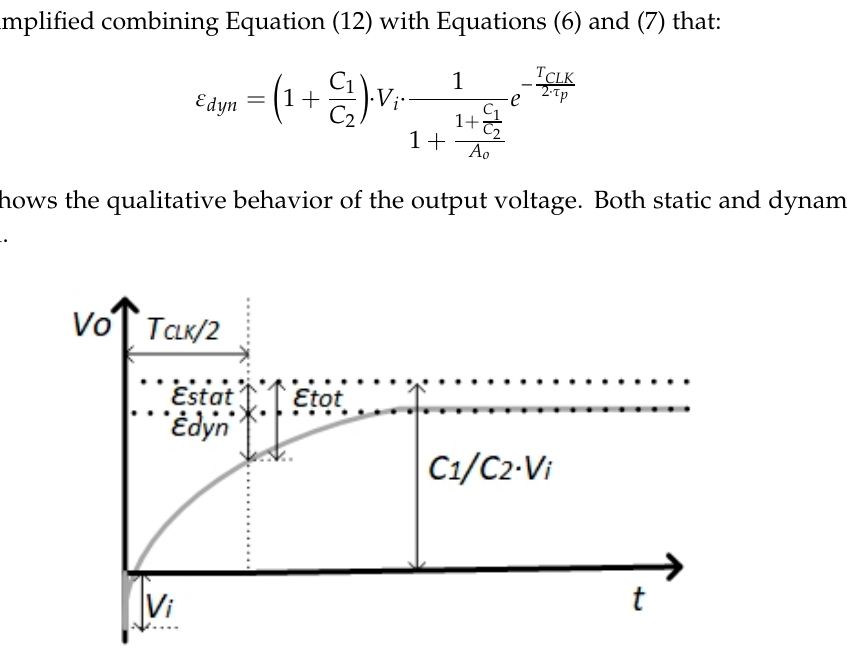
Figure 3. Output voltage behavior of the closed-loop switched-capacitor integrator in the linear regime.